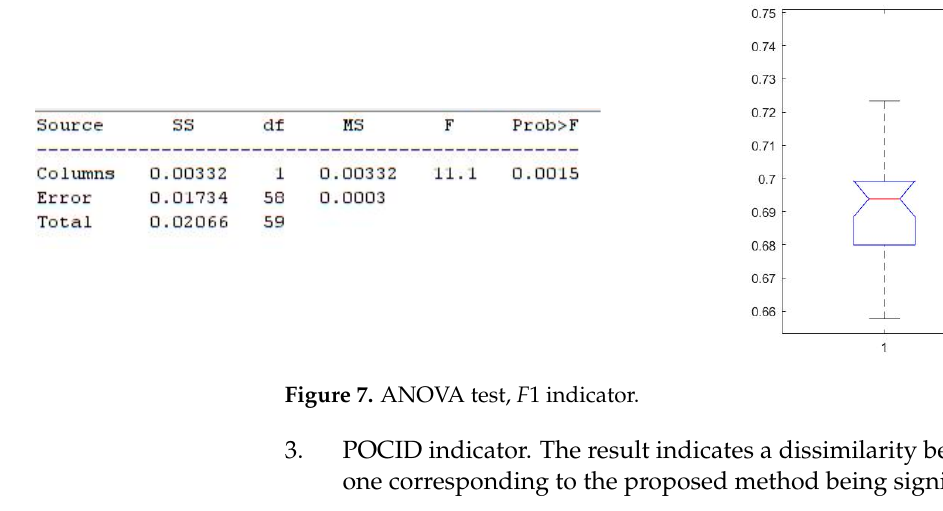
responding to the proposed method being better.